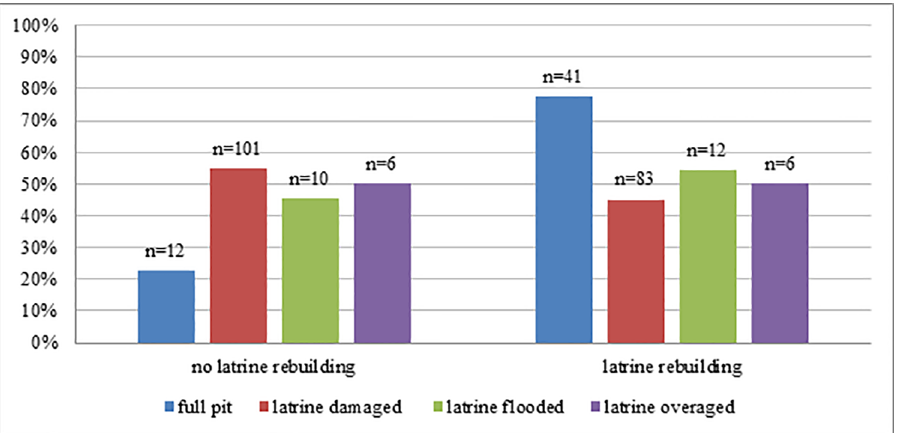
Fig 2. Latrine decommission and latrine rebuilding. Differences in latrine rebuilding related to the reported cause of latrine decommission.